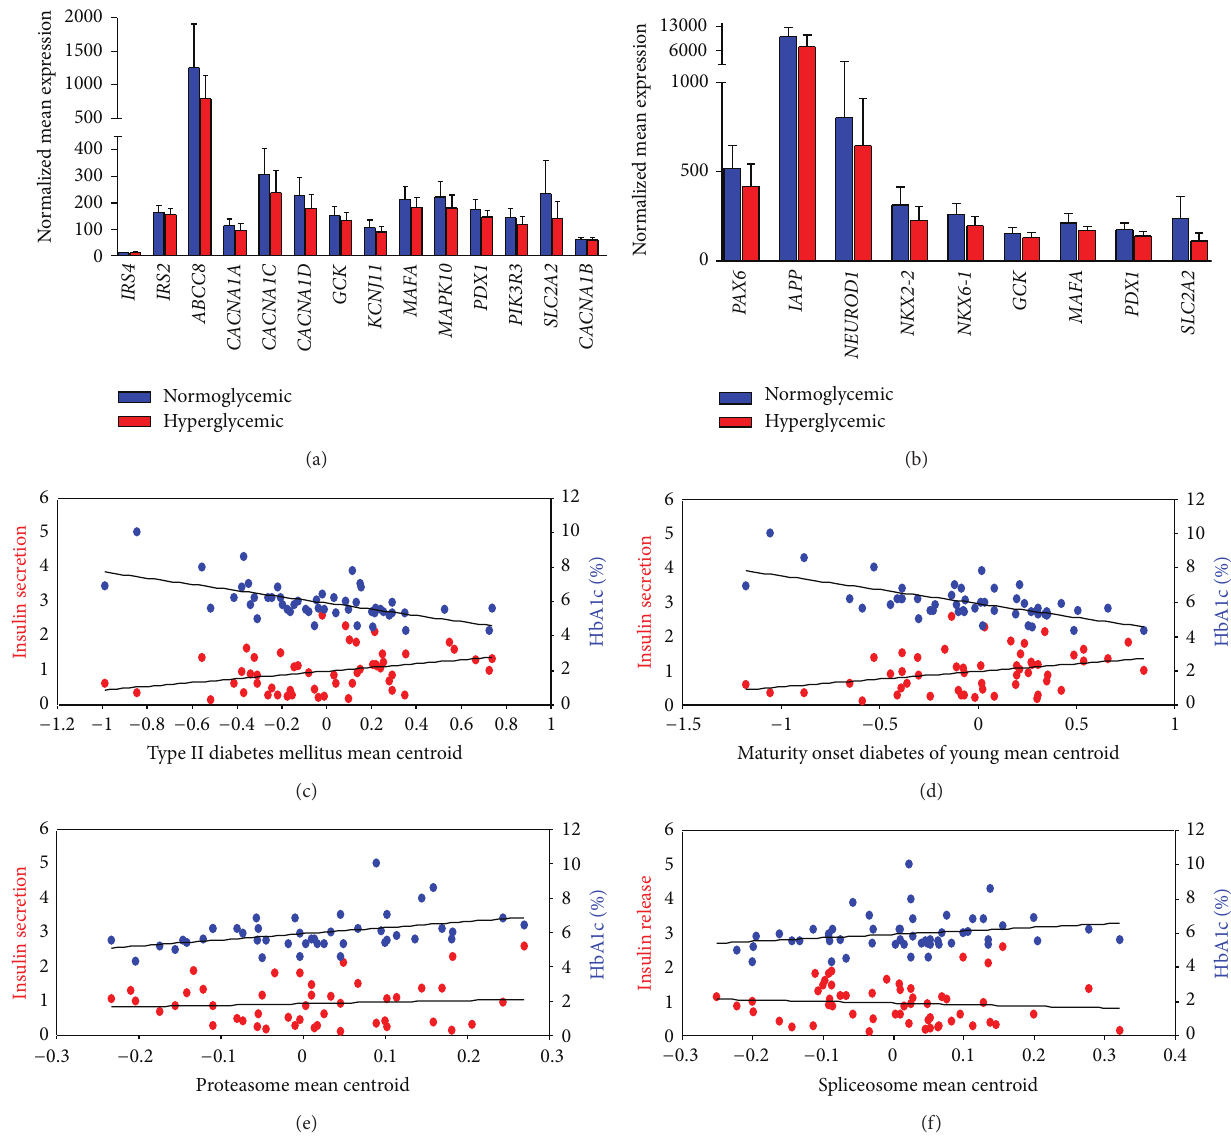
Figure 2: Genes differentially expressed in T2DM and MODY pathways. Gene expression analysis of genes in the T2DM and MODY pathway showed that 14 out of the 45 genes of the T2DM (a) pathway ( 𝑃 < 0.05 ) and 9 out of 24 genes of MODY (b) ( 𝑃 < 0.05 ) have lower expression in hyperglycaemic compared to normoglycemic donors. (c) Correlation of mean centroid of the 14 downregulated genes in T2DM pathway showed positive correlation with insulin secretion ( 𝑅 = 0.33 ; 𝑃 = 0.01 ) and negative correlation with HbA1c level ( 𝑅 = −0.57 ; 𝑃 = 0.00001 ). (d) Correlation of mean centroid of the 9 downregulated genes in MODY pathway showed positive correlation with insulin secretion ( 𝑅 = 0.31 ; 𝑃 = 0.01 ) and negative correlation with HbA1c level ( 𝑅 = −0.59 ; 𝑃 = 0.000006 ). (e) Correlation of mean centroid of the 31 upregulated genes in proteasome pathway showed no correlation with insulin secretion ( 𝑅 = −0.05 ; 𝑃 = 0.7 ) and positive correlation with HbA1c level ( 𝑅 = 0.3 ; 𝑃 = 0.03 ). (f) Correlation of mean centroid of the 55 upregulated genes in spliceosome pathway showed no correlation with insulin secretion ( 𝑅 = 0.16 ; 𝑃 = 0.23 ) and positive correlation with HbA1c level ( 𝑅 = 0.26 ; 𝑃 = 0.06